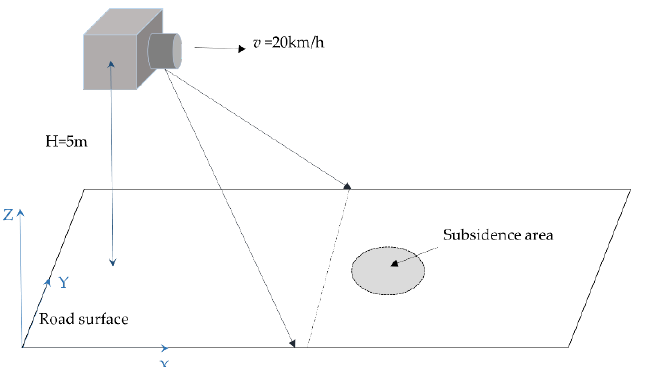
Figure 3. Diagram of simulation data acquisition.